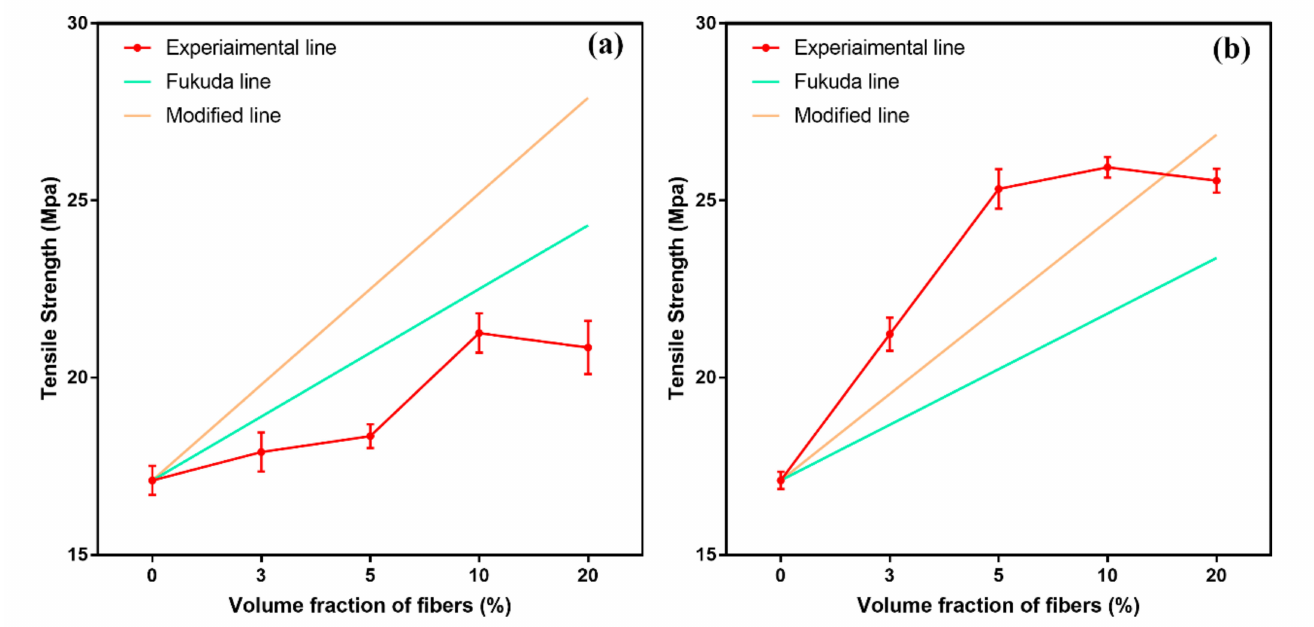
Figure 4. Experimental data and fitting line of tensile strength of composites ( a ) PBAT/HF; ( b )